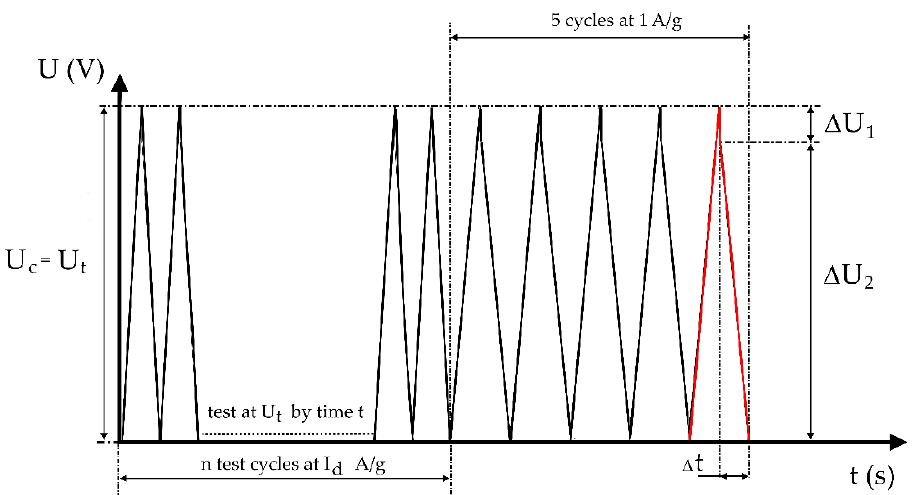
Figure 4. The applied way of determining values of capacitance C and resistance R ESR after temperature distribution measurements.